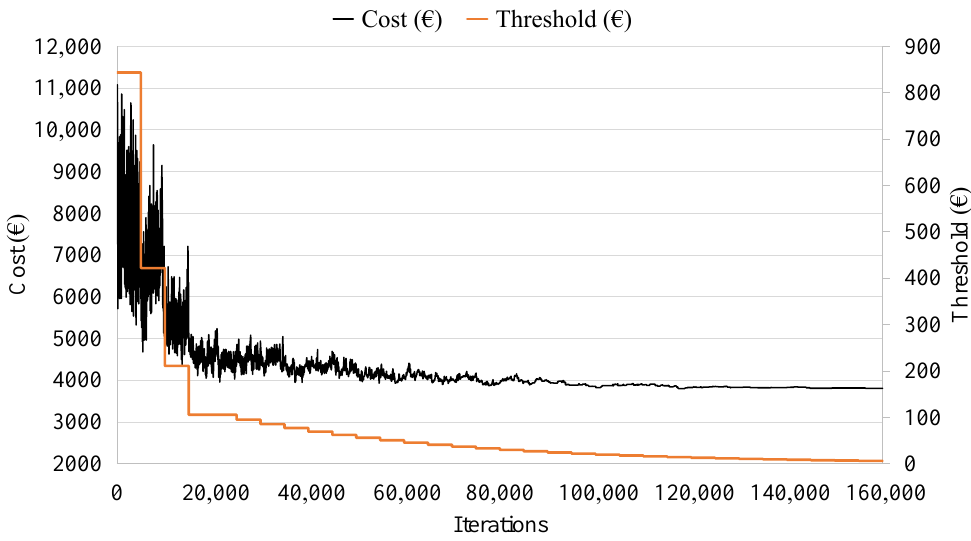
Figure 6. Threshold accepting trajectory for the cost and temperature as a function of